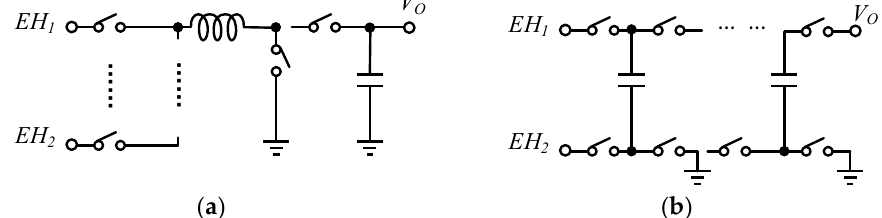
Figure 19. Architecture of energy combining ( a ) inductor-based, ( b ) capacitor-based.